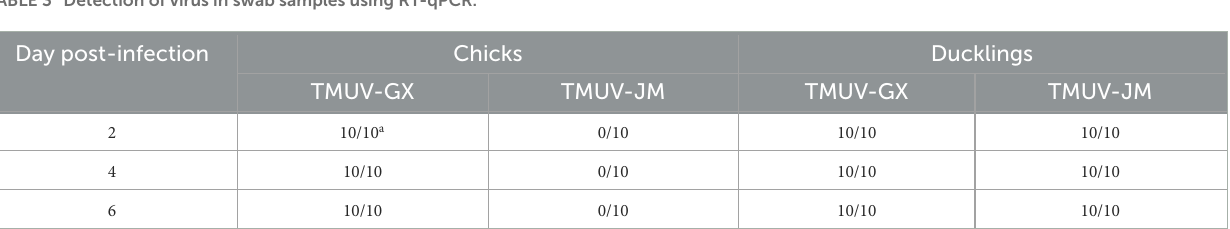
TABLE 3 Detection of virus in swab samples using